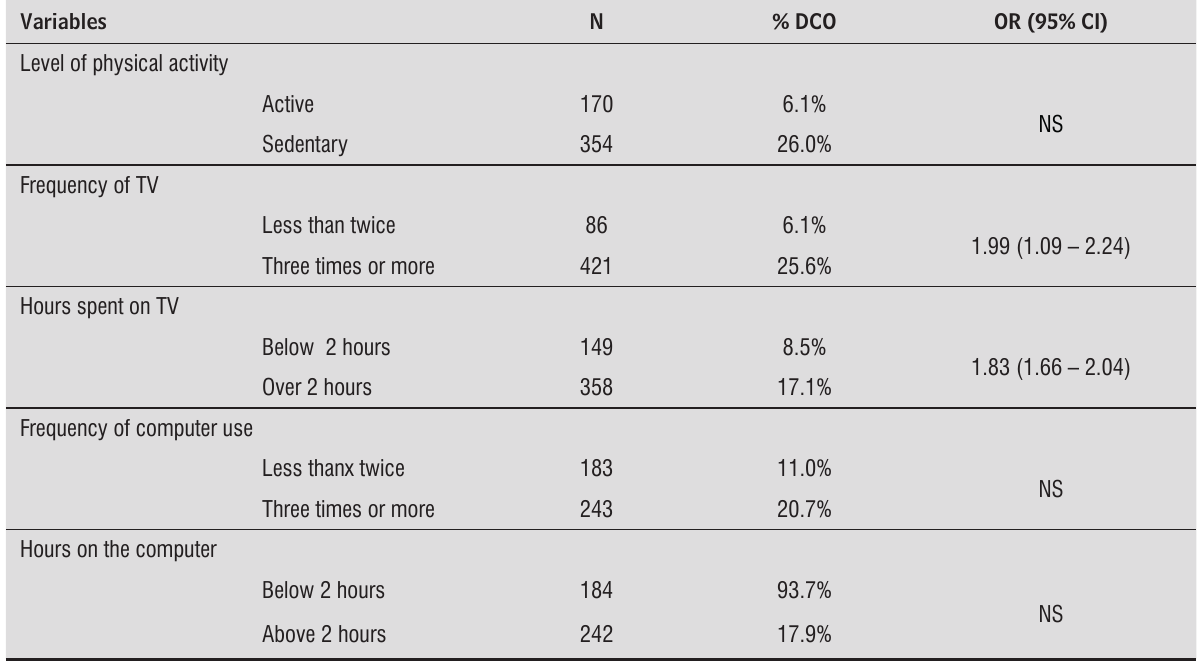
Table 3 - Result of the logistic regression multivariate analysis, final model for independent associations with pain in the neck/shoulders among female school students, Bauru -